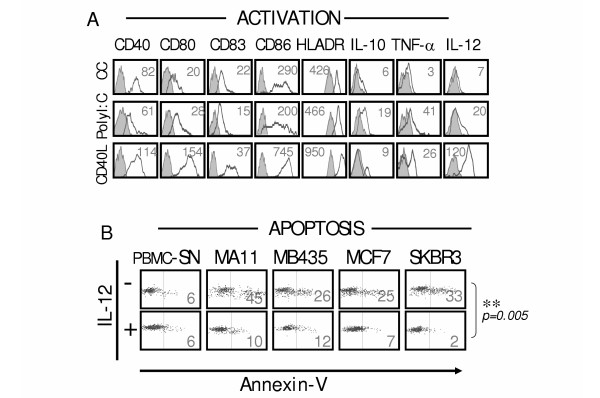
Protective effect of IL-12 on tumor-derived supernatant (TDSN)-induced apoptosis. (a)Expression of HLA-DR and co-stimulatory molecules (CD40, CD80, CD83 and CD86) as well as secretion of cytokines (tumor necrosis factor (TNF)-α, IL-10 and IL-12) was determined for blood DCs following stimulation (24 h) with a cytokine cocktail (CC), synthetic double-stranded RNA (poly I:C) or CD40 ligand (CD40L) as described in Materials and methods. Histograms indicate expression in the absence (shaded) or presence (non-shaded) of stimulation. Numbers indicate delta mean fluorescence intensity (ΔMFI, stimulated cells minus unstimulated cells) and are representative of five independent experiments. (b)TDSN-induced apoptosis in blood DCs was determined by Annexin-V binding following incubation (24 h) in the presence or absence of exogenous IL-12 prior to culture (24 h) with 50% (v/v) peripheral blood mononuclear cell-conditioned supernatant (PBMC-SN) or TDSN (MA11, MB435, MCF7 and SKBR3). Representative dot plots (SSC on y-axis versus apoptosis on x-axis) are shown with numbers indicating the percentage of apoptotic cells. Five independent experiments were performed for which the p-value is indicated.